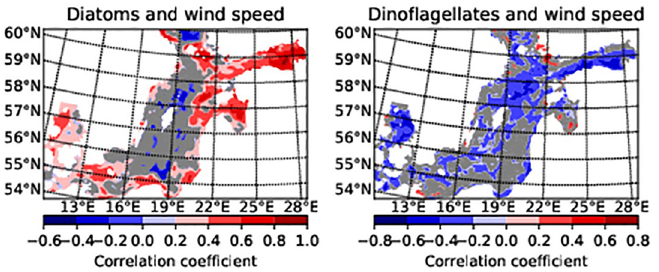
Fig 12. The correlation coefficient (R) between a 5-day moving average wind speed and phytoplankton biomass. The modelled dinoflagellates, diatoms, and ERA-5 wind on 5 April to 5 May 2010, 2011 and 2013 have been considered. N = 90 days, the critical value, Rcrit (P < 0.05) = 0.205, Rcrit (P < 0.01) = 0.267. The correlation in the red and blue areas is statistically significant (P < 0.05). Grey is statistically